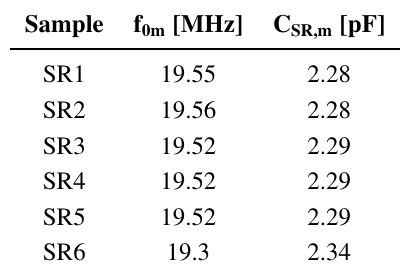
Table 1. Measured self-resonant frequency f each SR